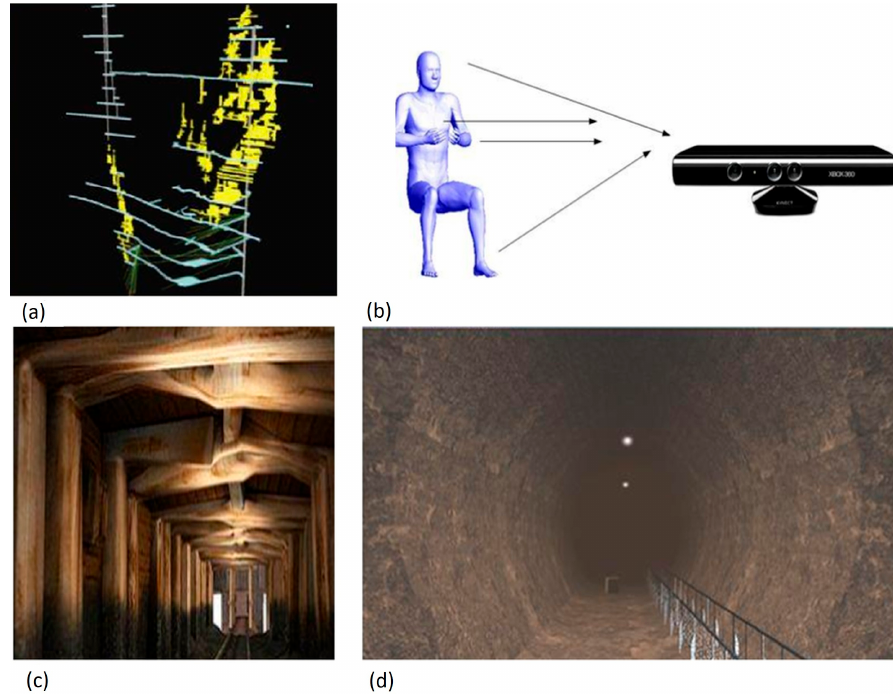
Figure 5. Three-dimensional virtual mine modeling using Microsoft Xbox and Kinect for ( a ) three- dimensional model of a mine working in AutoCAD format; ( b ) transferring digital avatar control gestures using Kinect; ( c ) game visualization of the mine working model after Blender processing; ( d ) an example of driving through a mine working based on the PhysX game engine (Adapted from Refs. [47,48]).